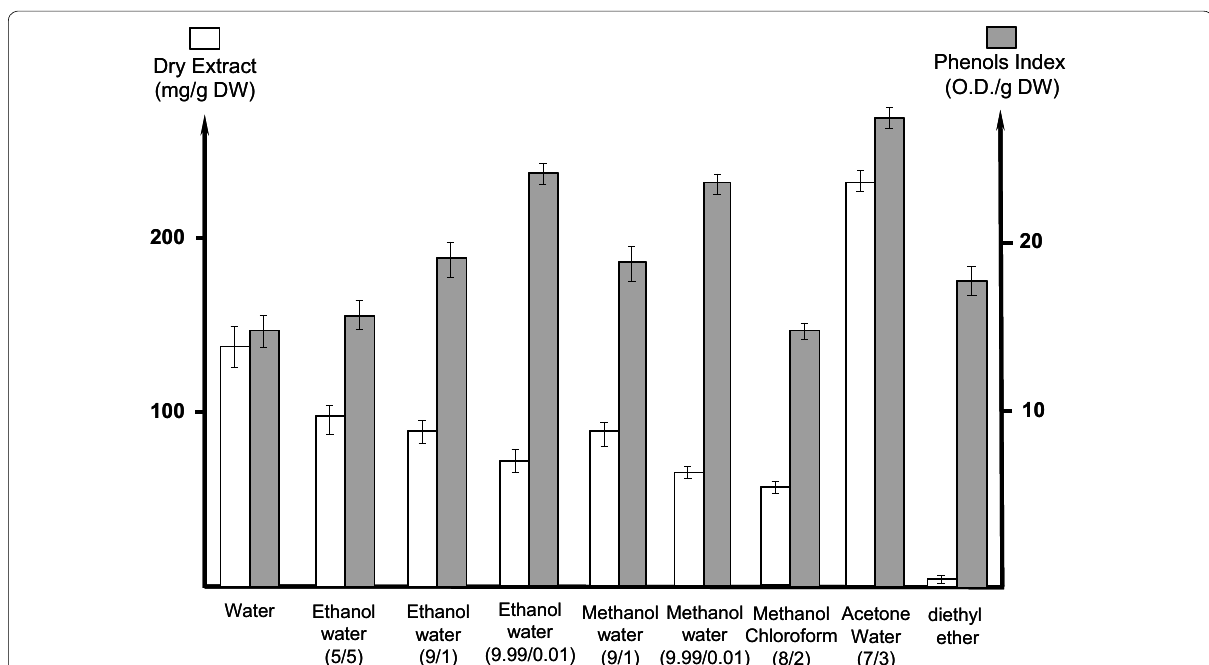
Fig. 1 Dry extract and phenols index measured on several solvents and solvents mixtures of Q. robur heartwood. Extraction of 1 g/100 mL of solution, 60 mesh sawdust, at room temperature, in dark. Results expressed the average of triplicate measure per gramme of dry wood